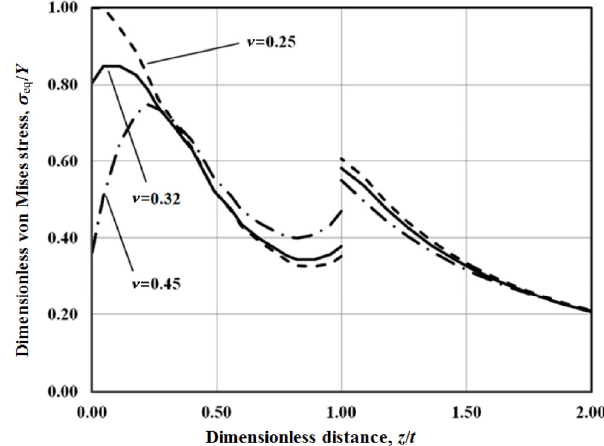
Fig. 7 Dimensionless von Mises equivalent stress along the axis of symmetry ( t/R = 0.0045, E co /E su = 4,  y_su =  y_co = 0.001,  / R = ω / R = 1 × 10 –5 and  = 0.32).